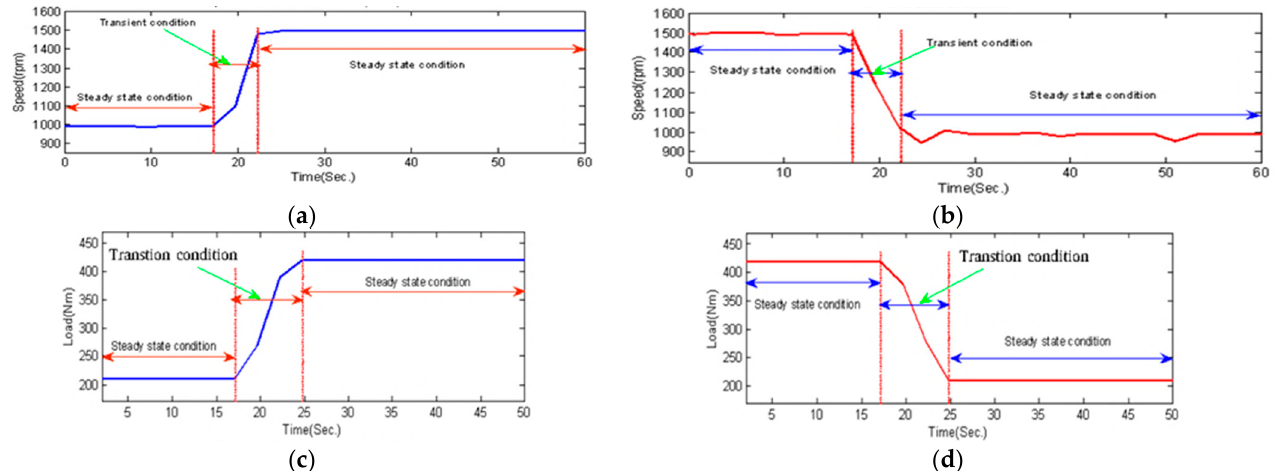
Figure 2. Speed transient profiles. ( a ) Acceleration at 1000 to 1500 rpm; ( b ) deceleration at 1500 to 1000 rpm. Torque transition profiles for ( c ) positive torque transition from 210–420N and ( d ) negative transition from 420–210 Nm.